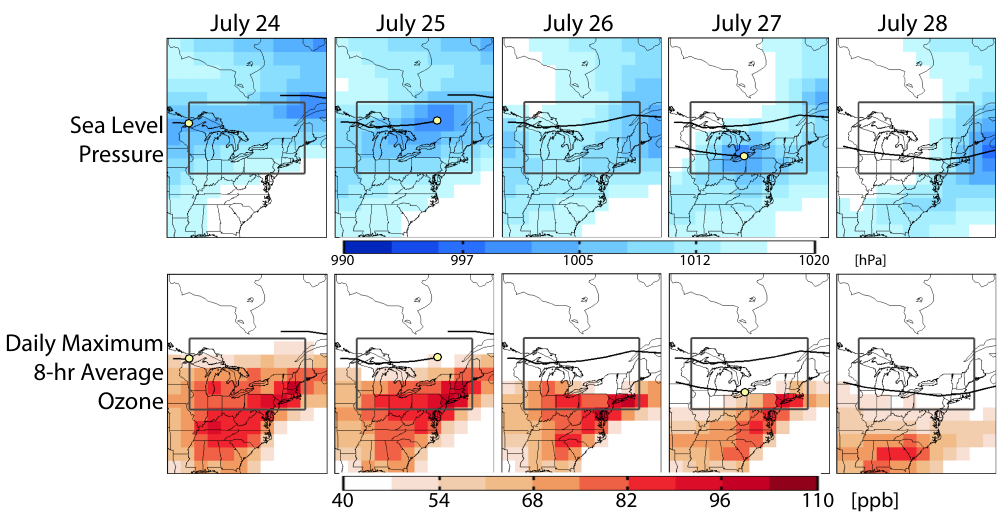
Fig. 1. A clearing event simulated in the GFDL CM3 GCM from 24 July to 28 July for a year selected from the GCM RCP 8.5 simulation. The top row shows the sea level pressure at 9Z and the bottom row shows the daily maximum 8-h average ozone concentration in surface air. The gray box in all panels indicates the GLST and the black lines are storm track. The yellow dot indicates the position of the storm at the current time step. Storm tracks without a yellow dot are storms that still meet the criteria described in Sect. 2.2 but have moved out of the